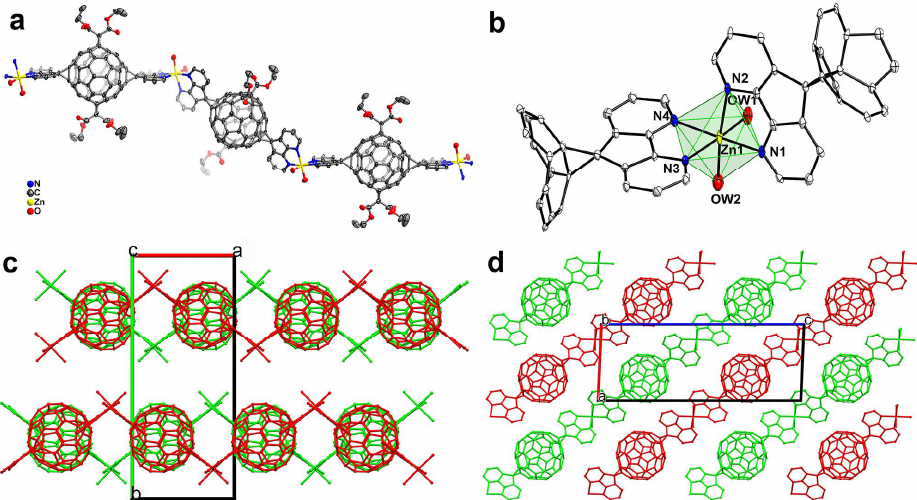
Figure 2. ( a ) A drawing of a portion of the 1D stair-like chain structure of compound 1 with thermal ellipsoids shown at 50%, front and back malonate addends and all hydrogen atoms have been omitted for clarity; ( b ) coordination environment of Zn(II) in 1 with 25% thermal contours; ( c ) packing mode of 1 along the a -axis; ( d ) ABAB-type alignment of individual layers. Hydrogen atoms and malonate addends have been omitted for clarity.